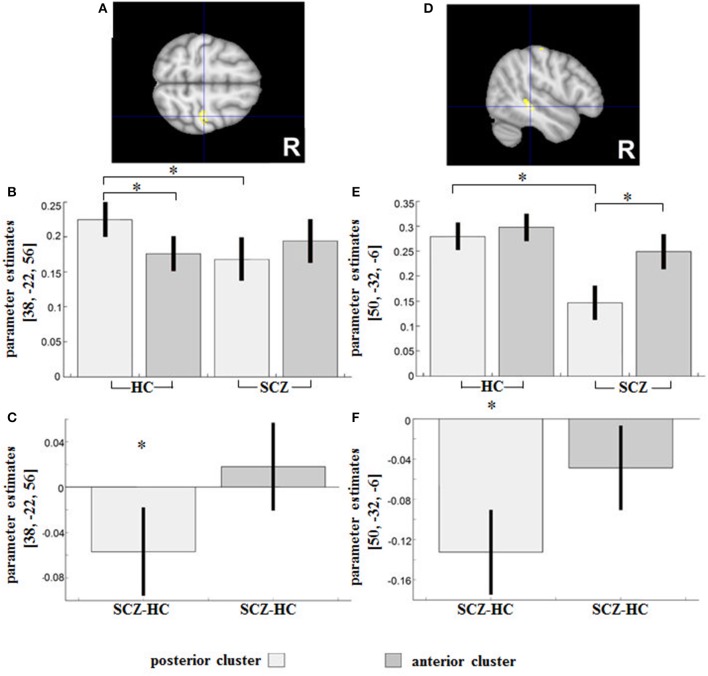
Regions showing an SCZ-related (relative) decreased functional connectivity with the posterior compared to the anterior DLPFC seed were (A) the right precentral gyrus and (D) the right middle temporal gyrus. Contrast estimates for the effect in the respective region are shown under (B,E). Parameter estimates depict the difference in RSFC between HC and SCZ for the posterior and anterior DLPFC seeds respectively and are shown under (C,F). *indicates the significant effects of the interaction assessed with t-tests (p < 0.05 family-wise error (FWE)-corrected on the voxel level).